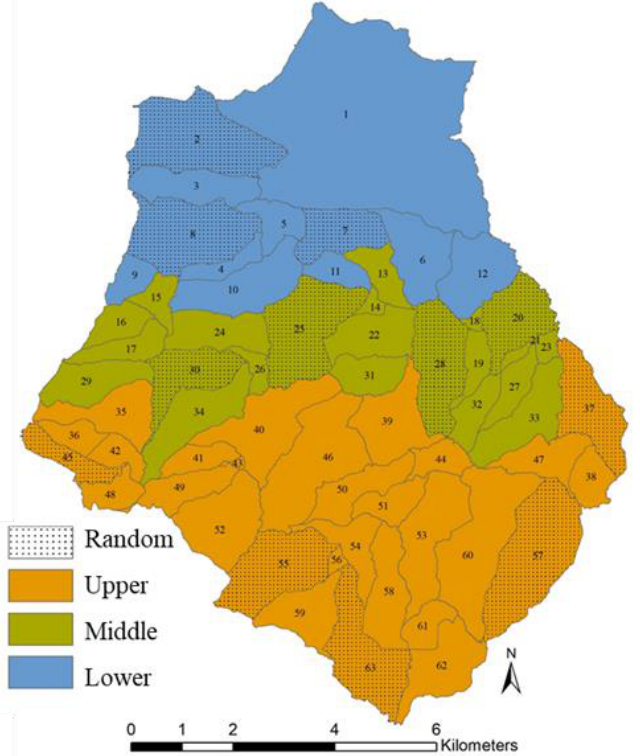
Figure 3. A map of the Vrchlice Basin, color coded to represent the various scenarios analyzed.